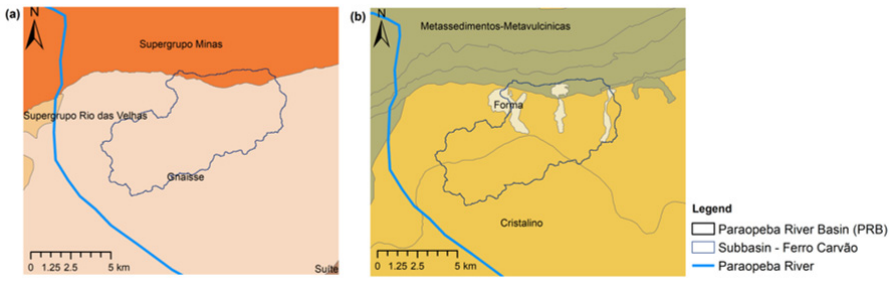
Figure 5. The ( a ) Geology, ( b ) Hydrogeological domains at the Ferro Carvão